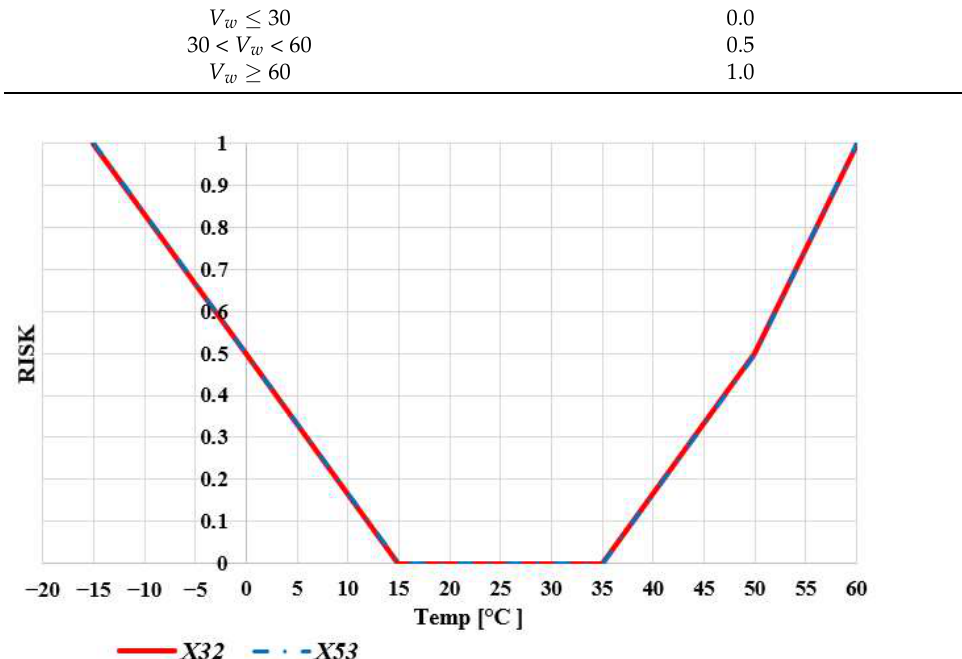
Figure 3. Relation between temperature and risk value. Table 1. Relation between wind force and risk values. Table 2. Relation between relative humidity and risk